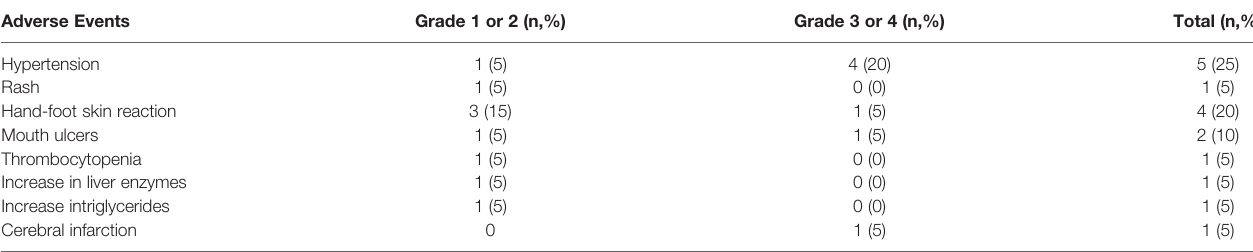
TABLE 4 | Analysis of adverse